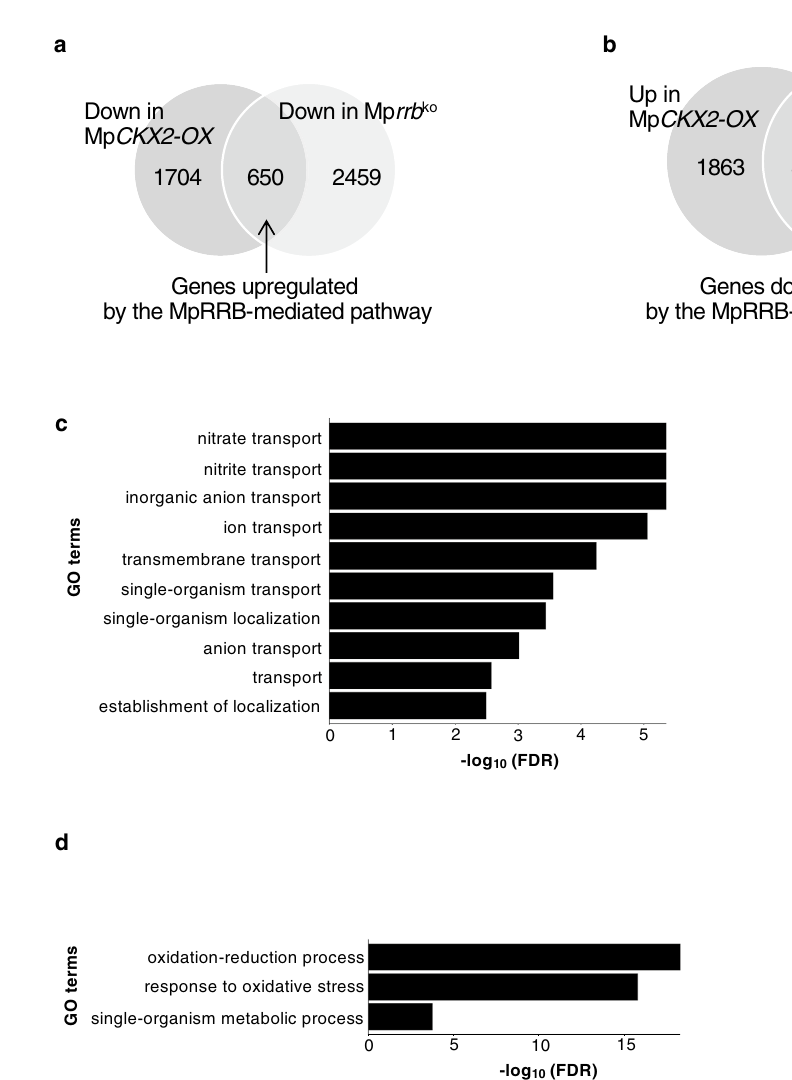
Figure 1. Identification of genes downstream of cytokinin signaling. ( a,b ) Venn diagrams overlap among genes with more than a ( a ) decreased or ( b ) increased transcript level of 1.5-fold in both the Mp CKX2 -overexpressing line and the Mp rrb knockout line compared to the wild-type. ( c,d ) GO terms of gene sets ( c ) upregulated or ( d ) downregulated by MpRRB-mediated cytokinin signaling. Overlaps shown in ( a,b ) were subjected to GO enrichment